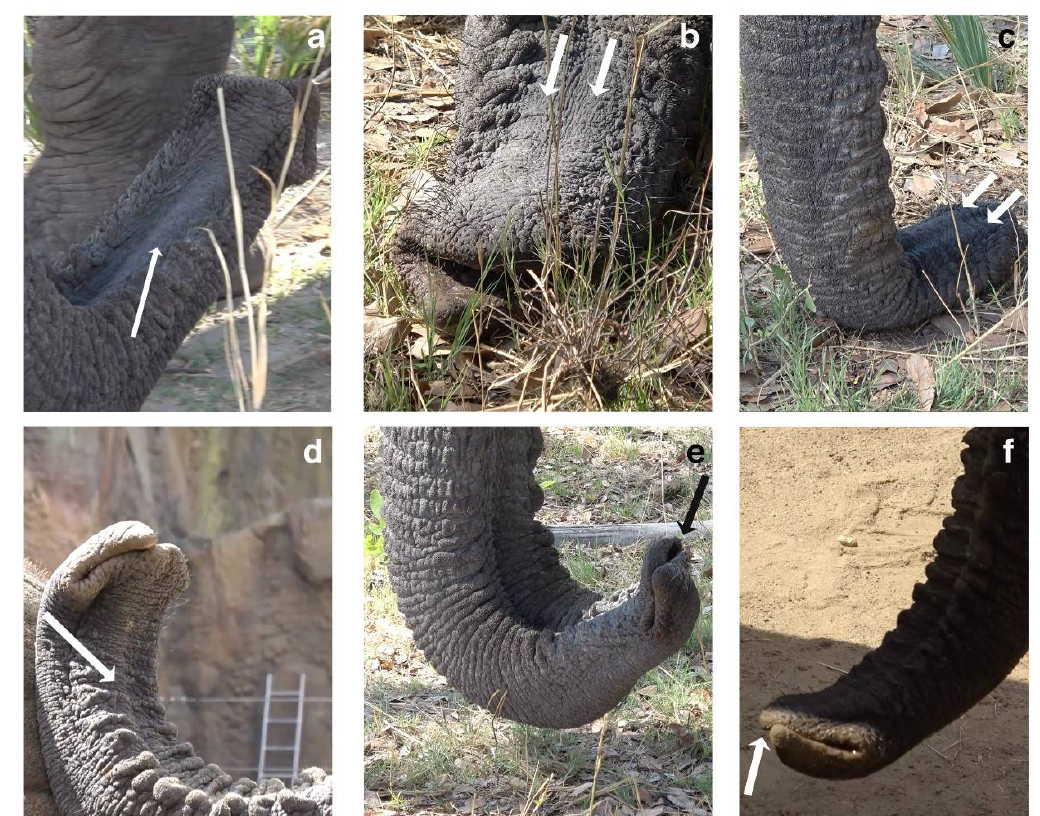
Figure 1. Observations during high-frequency sound (HFS) production. ( a ) shows Jabu stiffening only his left nasal tube during HFS production. ( b ) Jabu’s trunk is resting on the ground (not vocalizing), both nasal tubes are quite relaxed. ( c ) shows Morula’s trunk (not vocalizing), both of her nasal tubes are stiffened and clearly visible. ( d ) Sawu during HFS production, stiffening and closing off her right nasal tube. ( e ) Jabu during HFS production: his left nasal tube is closed, the opening of the right one is visible and marked with the black arrow. ( f ) shows how Sawu is actually crossing the fingers of the trunk during HFS production.